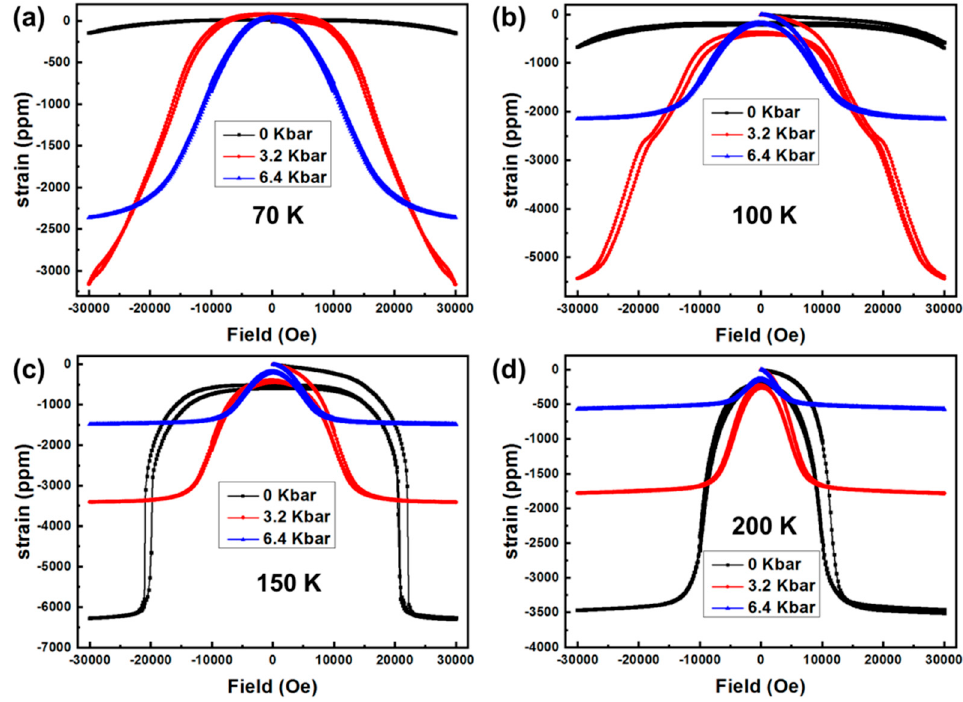
Figure 3. Isothermal magnetostriction under various pressure ( a ) 70 K, ( b ) 100 K, ( c ) 150 K and ( d ) 200 K.